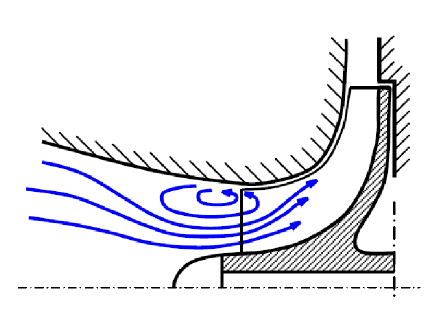
Figure 8: Flow structure of the inlet recirculation (after [13–15]).